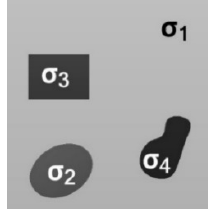
Figure 3. Multiple sub-pixel targets in a pixel; where σ 1 is the roughness of the main region of the pixel, and σ 2,3,4 denotes the roughness of the interfering sub-pixel regions.